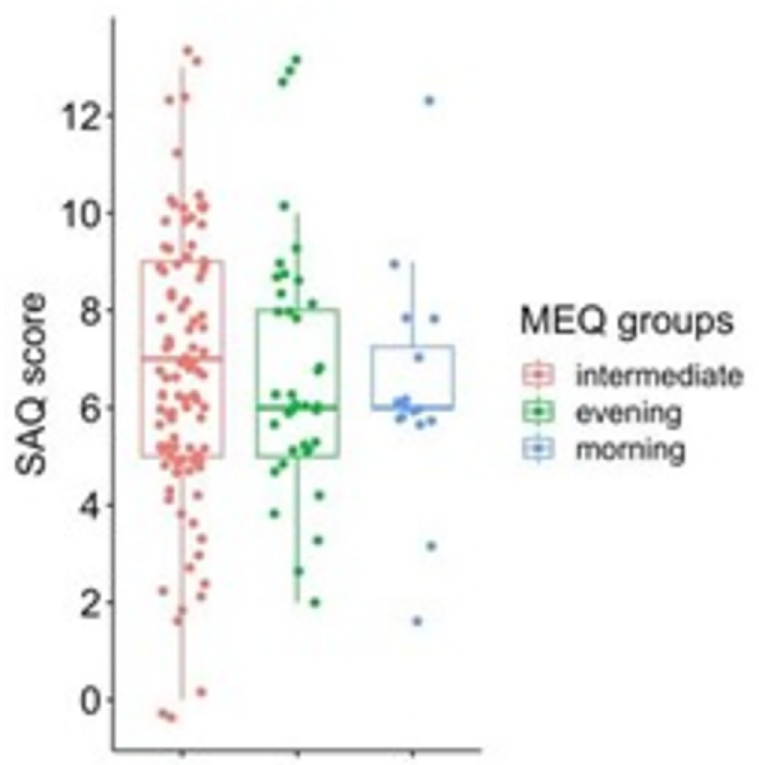
Fig 4. Distribution of the SAQ scores depending on the respondent’s circadian preference group. Each boxplot contains the interquartile range (i.e., the range containing 50% of all observations) and the median value (middle line), while the whiskers represent values extending outside 50% of the